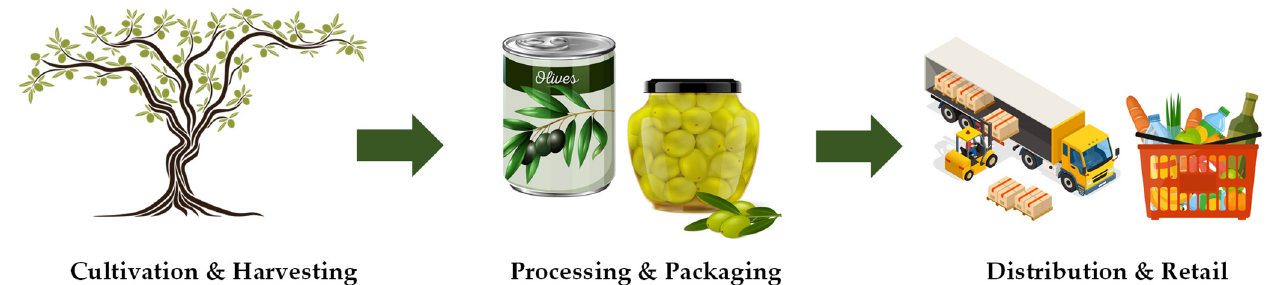
Figure 1. Major Table Olives Supply Chain Stages.